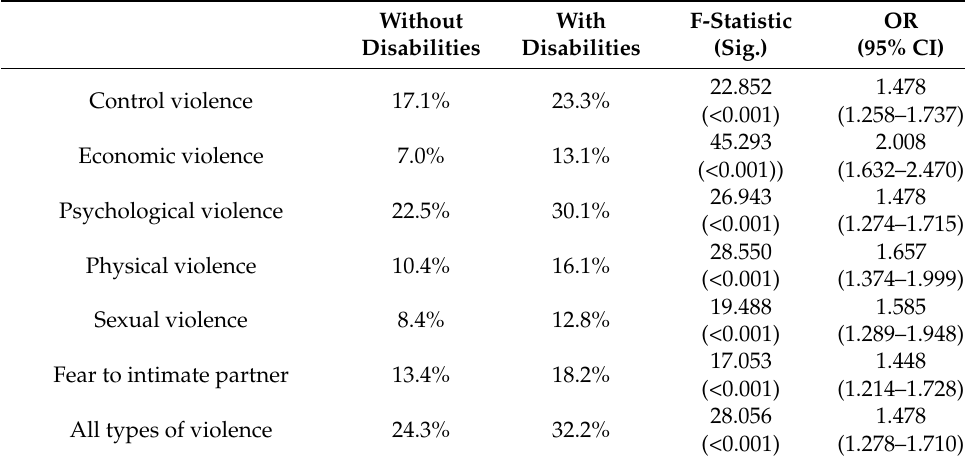
Table 2. Incidence of IPV experienced by women with